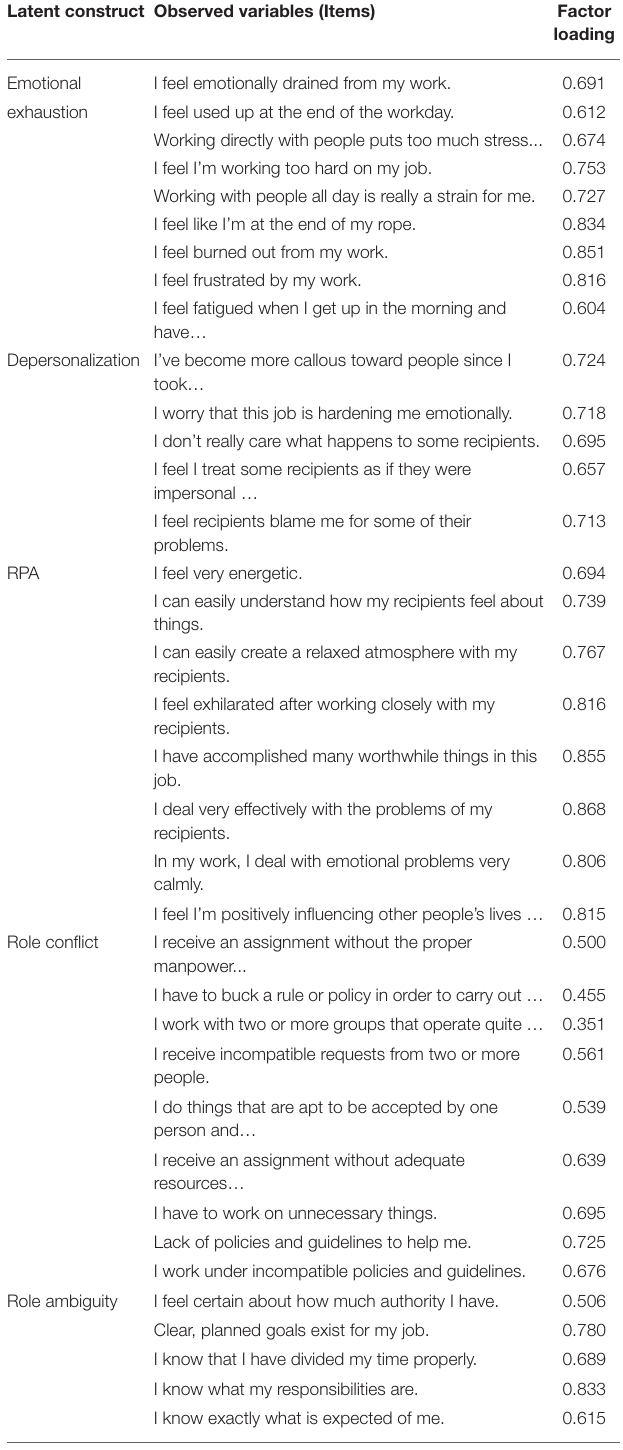
TABLE 4 | Standardized factor loadings of observed variables on latent construct. Latent construct Observed variables